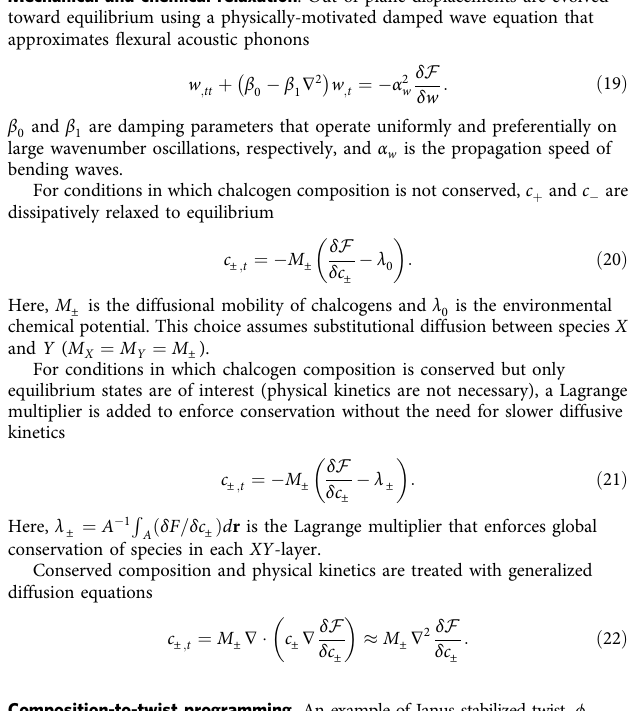
Composition-to-twist programming . An example of Janus-stabilized twist, ϕ , between two MoSeS monolayers with sinusoidal Janus patterns programmed along crystallographic directions separated by ψ ¼ 15 (cid:12) is shown in Fig. 5. The energy increase between ϕ ¼ 0 (untwisted) and large ϕ (twisted) states has been calculated for MoS 2 bilayers from fi rst principles 87 to be (cid:4) 0 : 02 Jm (cid:2) 2 . For Janus patterned bilayers with ψ ≠ 0, the dipole anti-alignment imposed by Janus-misaligned states ( ϕ ≠ ψ ) leads to an